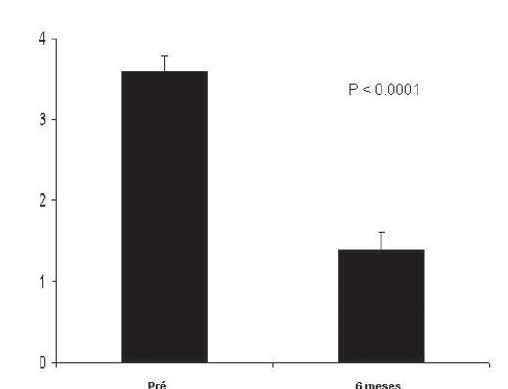
Fig. 2 - Classe funcional de angina (CCS) pré e seis meses após o procedimento. Observamos redução significativa da classe funcional de angina de 3,7± 0,2 (pré-operatório) para 1,3± 0,2 (seis meses de pós-operatório), p< 0,0001